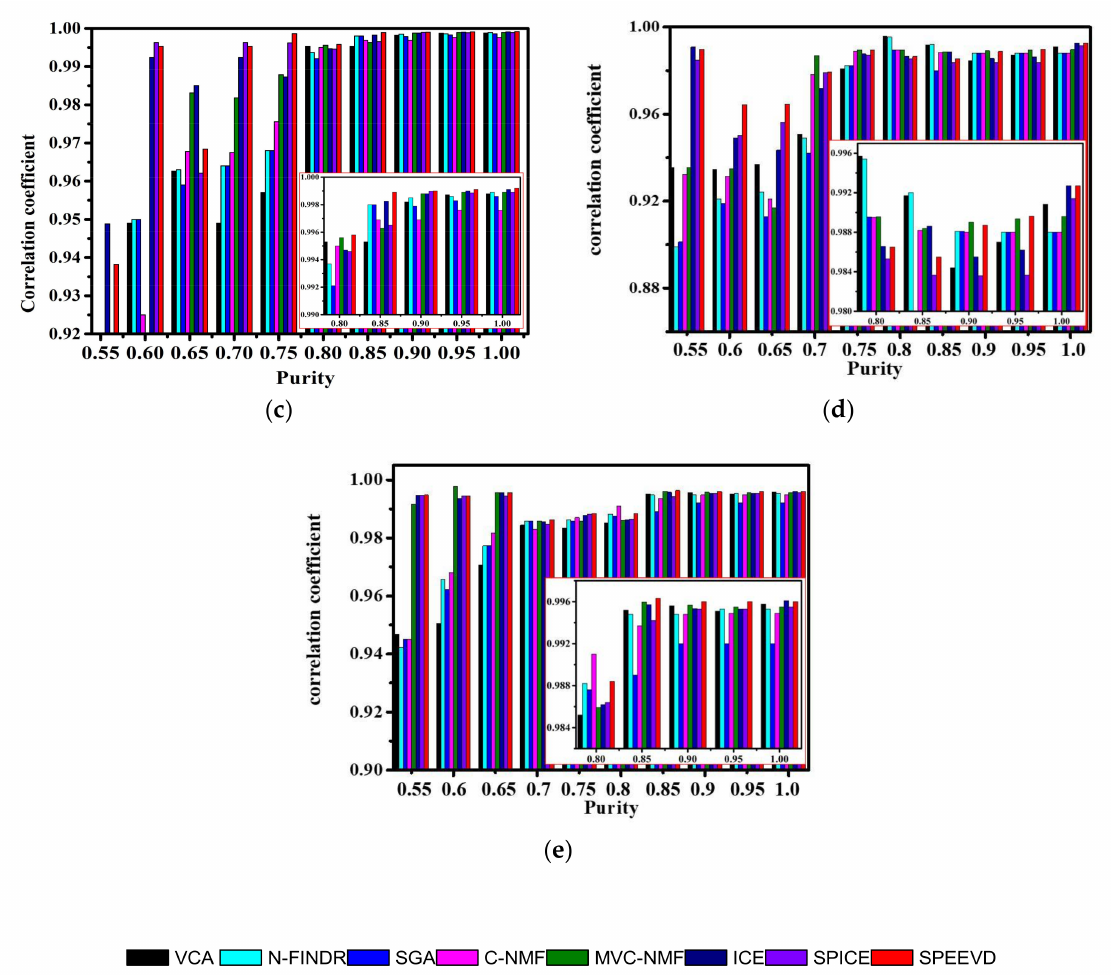
Figure 7. Correlation coefficients with different purities: ( a ) Carnallite, ( b ) Chlorite, ( c ) Clinochlore, ( d ) Clintonite, ( e )